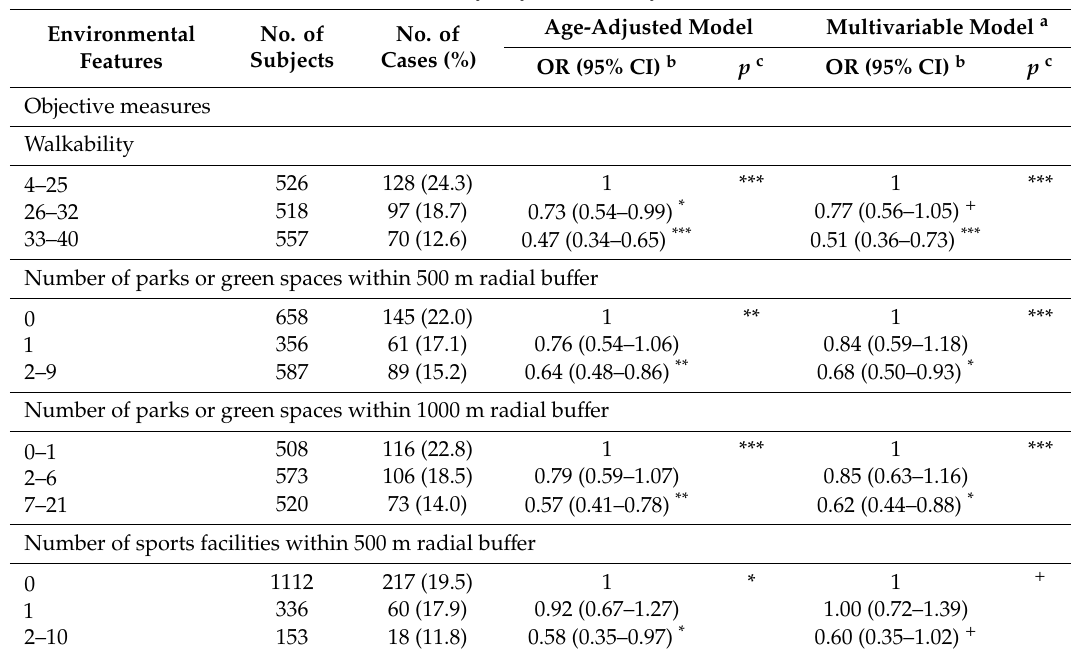
Table 3. Odds ratios for habitual moderate-intensity physical activity according to built neighborhood environmental features among retired civil servants, Aichi Worker’s Cohort,